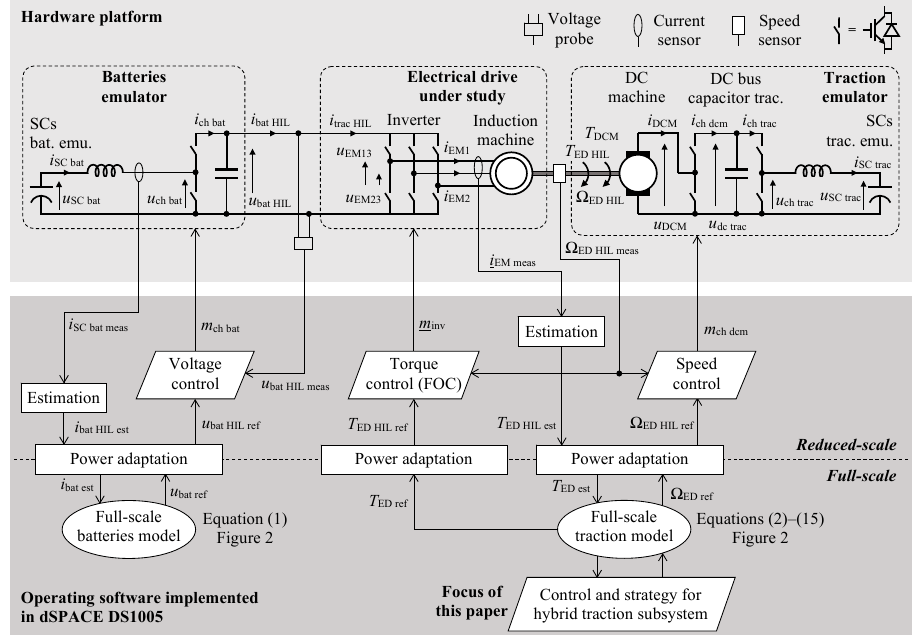
Figure 10. Experimental setup configuration.